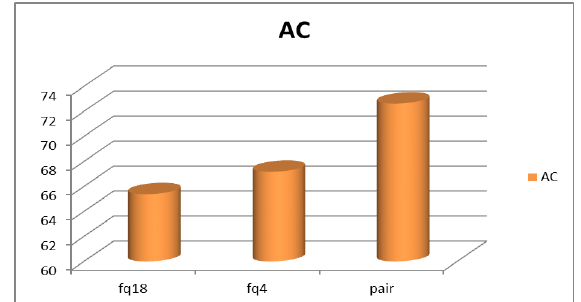
Figure 3 classification accuracy for FQ4 image Also, the overall accuracy of the simultaneous classification by using the extracted covariance matrix from both images is 72.63%. Figure 3 shows the classification accuracy for each of the class.